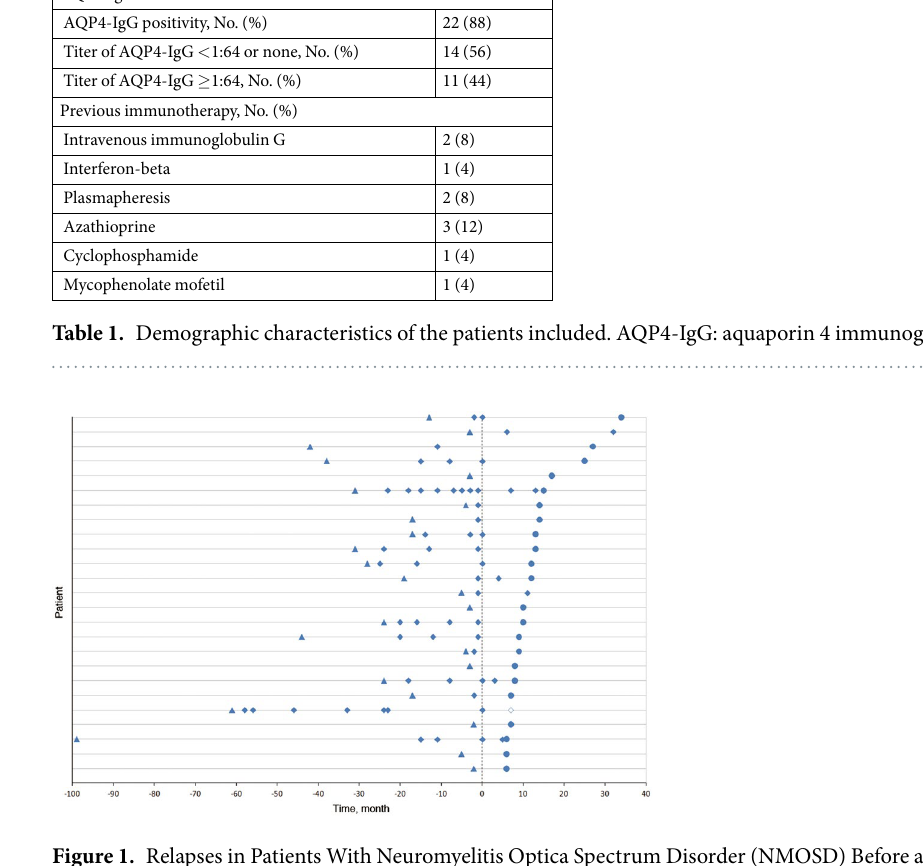
Results Baseline demographic and clinical data.